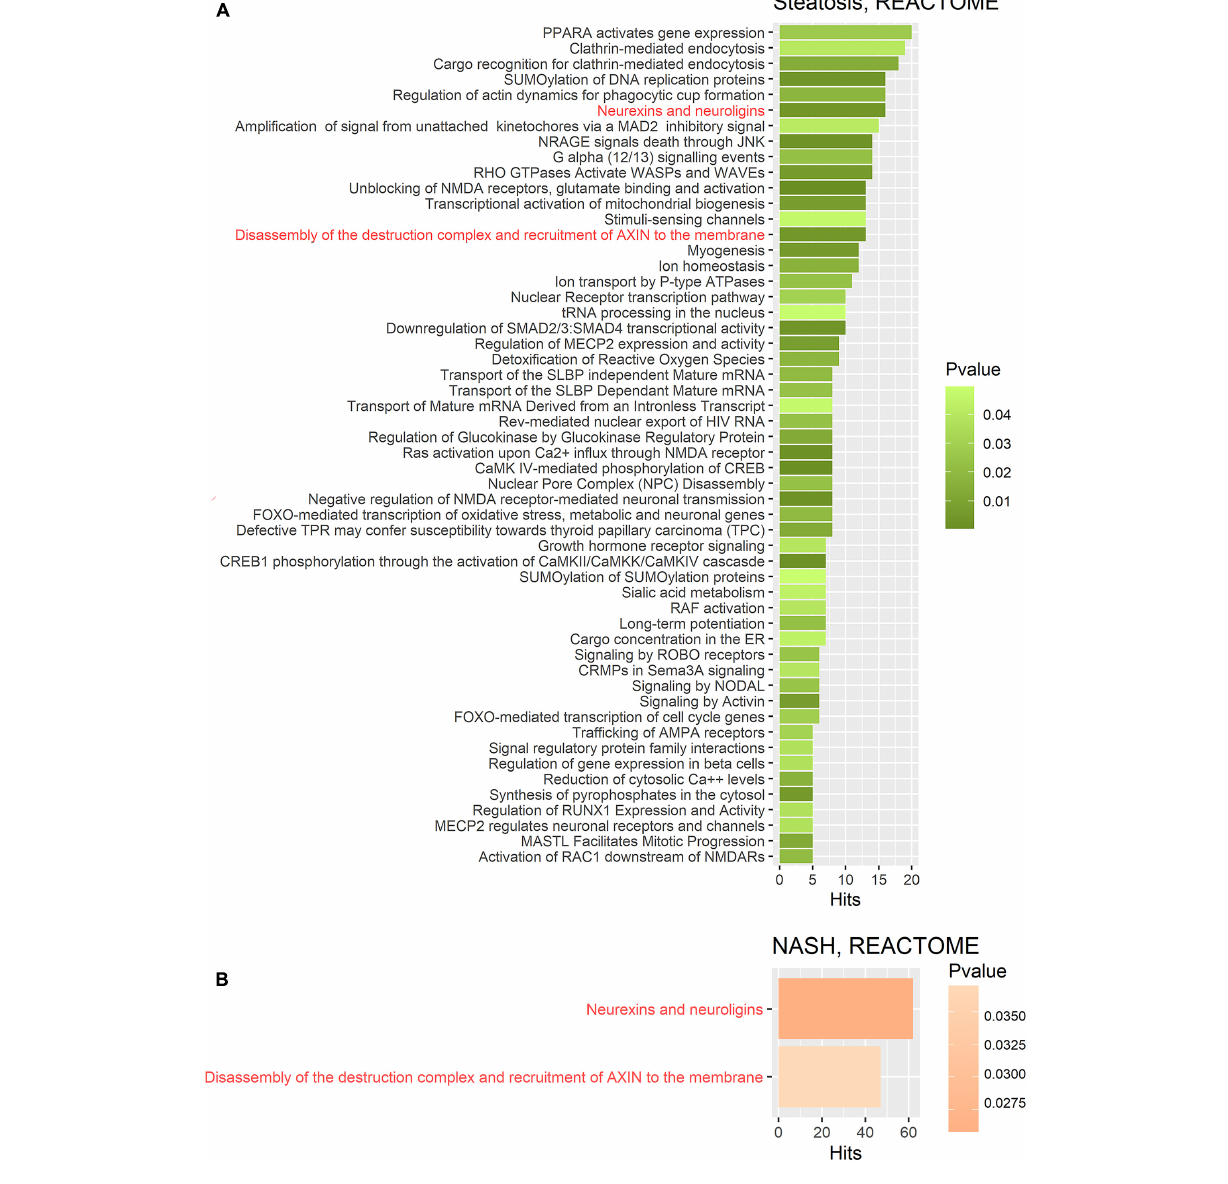
in the number of differentially expressed miRNAs in NASH is associated with pathology